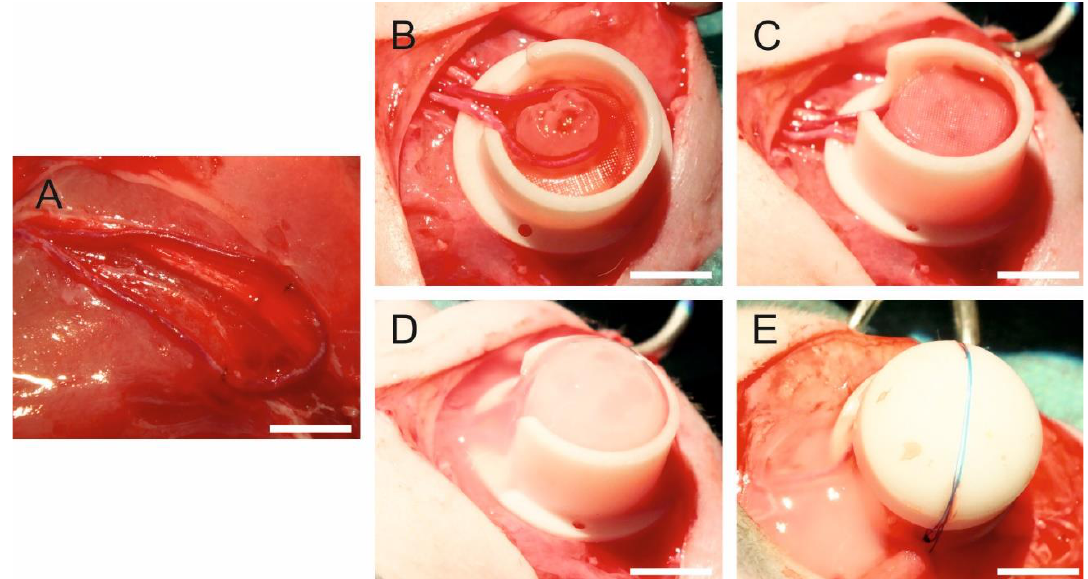
Figure 1. Arteriovenous (AV) loop operation in the rat. ( A ) The vessels were separated and the vein graft harvested from the right side was anastomosed with the femoral vein and artery of the left side to form the AV loop. ( B ) One 3D alginate – fibrin ring with cells was placed inside the loop, which was on three PCL scaffolds. ( C ) The other ring with cells was put around the AV loop, and another three PCL scaffolds with HTB-26 cells were put on the AV loop. ( D ) One piece of 3D printed alginate – fibrin sheet without cells was placed on the top and the chamber was filled with matrix. ( E ) The chamber was closed with a lid and fixed on the thigh. Scale bar 1 cm.